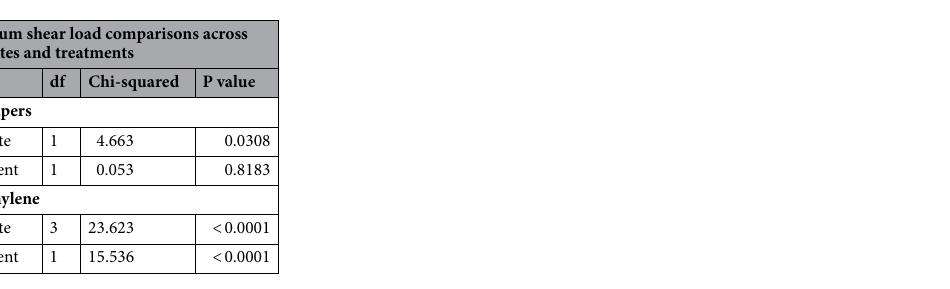
Table 2. Statistical results of maximum shear load performance across all tested substrates and